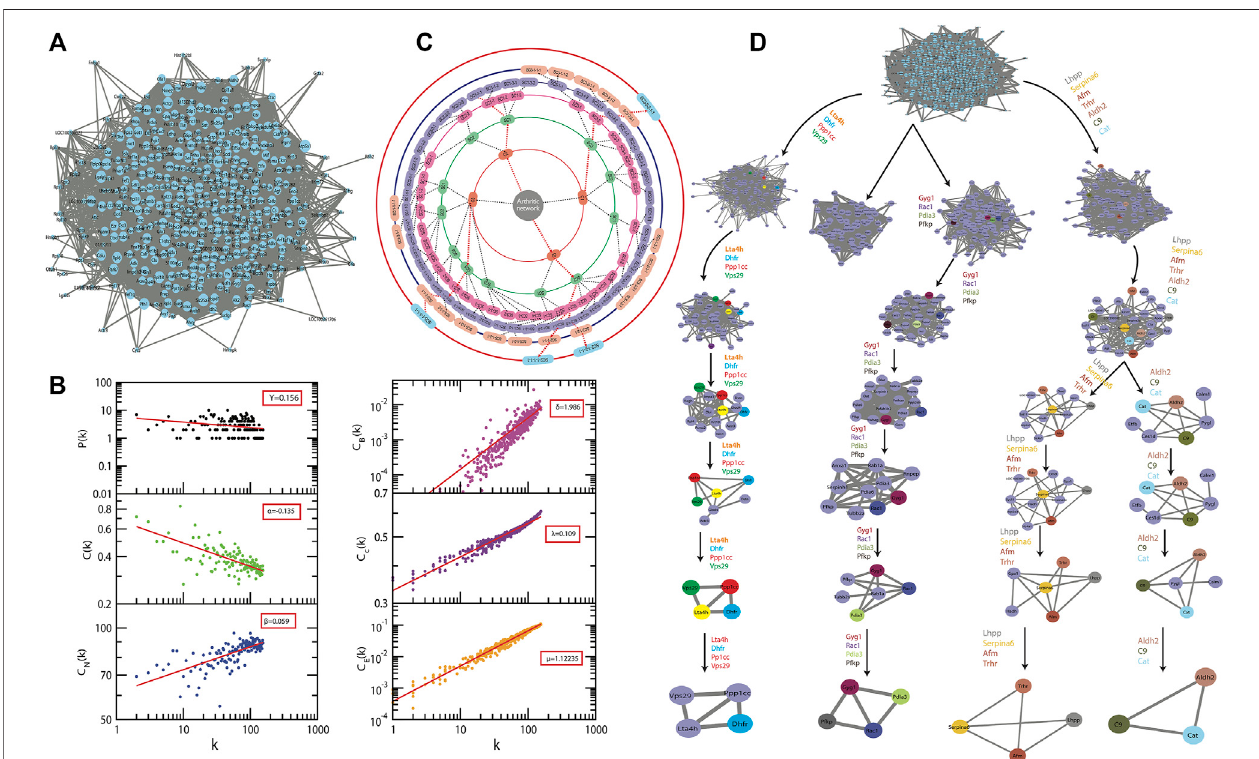
FIGURE5| Asystemlevelorganizationofproteinnetworksinarthritismodels. (A) The fi gureshowsallthenetworkscomprisingall434proteins;thisisthe fi rstlevel oftheproteinnetwork. (B) TheplotsofLCP-correlationisafunctionofCNforeachmodule/submodule(plotscorrespondtoeachmodule/sub-moduleofthenetwork)of C9 path. This also contains the plots of PH and PLCP as a function of the level of organization. (C) Organization of sub-modules and modules at different levels as indicated by concentric circles while the arrows indicate sub-modules built from previous modules leading to the identi fi cation of key regulators of the arthritis network. (D) Themodularpathofthekeyregulatorproteinsfromcompletenetworktomotifwiththestructuresofmodules/submodulesatdifferentstagesofcommunity fi nding. This leads to fi nding out three sub-modules through which the fi rst four leading hubs passed through. These leading hubs comprise of the 15 in silico key regulators and the probability distribution of the latter is a function of the degree of